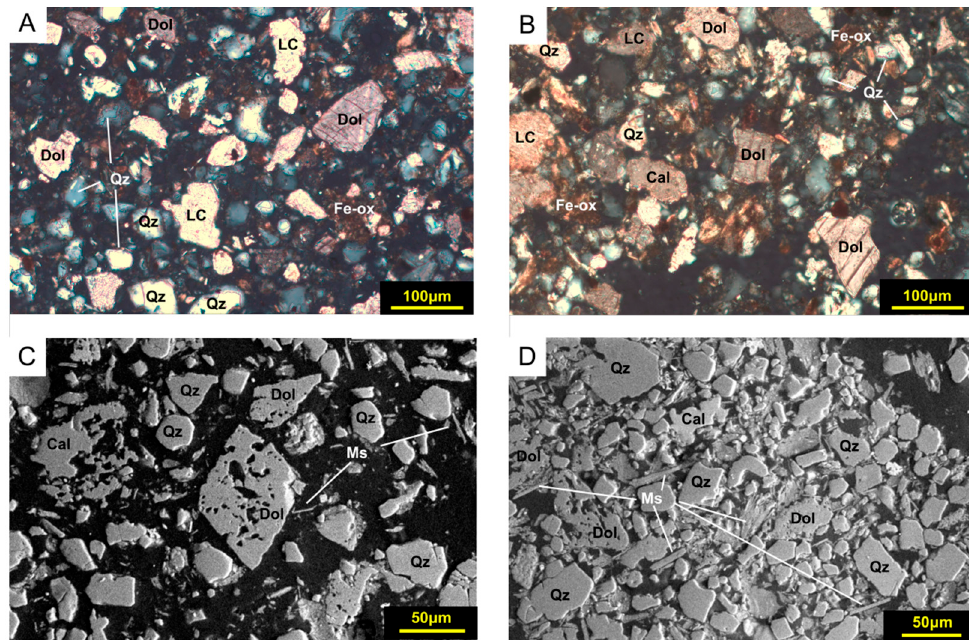
Figure 4. View of the chamber where the fine-grained cave deposits were sampled (upper images, after 3D mapping). The red star depicts the exact deposit site. View of the passage with its height distribution in a color scale (upper right image). The fine-grained deposits and corresponding sampling points are depicted with black circles (bottom image).The yellow ellipse indicates the figure of the researcher operating the 3D scanner.